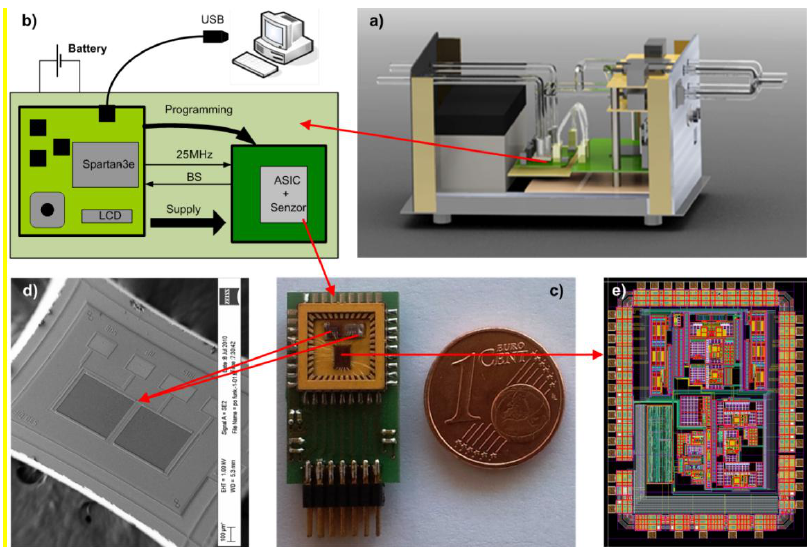
Figure 13. The demonstrator: ( a ) The complete demonstrator; ( b ) Complete electronics; ( c ) System in Package (SiP) with low-noise ASIC in 0.25  m BDC technology and two differently modified sensors; ( d ) One differential sensor, and ( e ) Layout of the